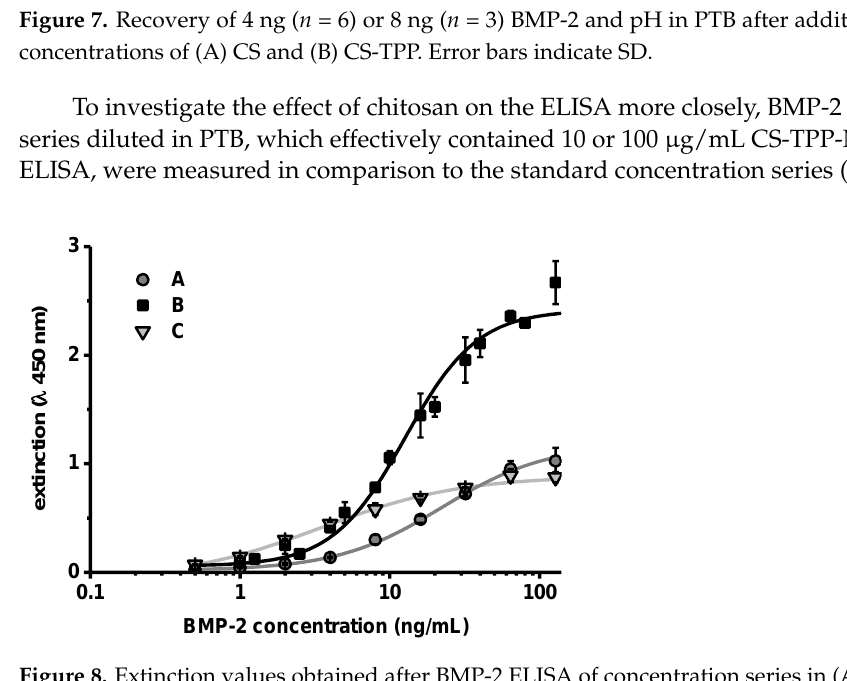
with 100 µg mL − 1 chitosan (CS) or (C) PTB with 10 µg mL-1 CS (CS added as CS-TPP nanoparticles with 100 µ g mL − 1 chitosan (CS) or (C) PTB with 10 µ g mL − 1 CS (CS added as CS-TPP nanoparticles